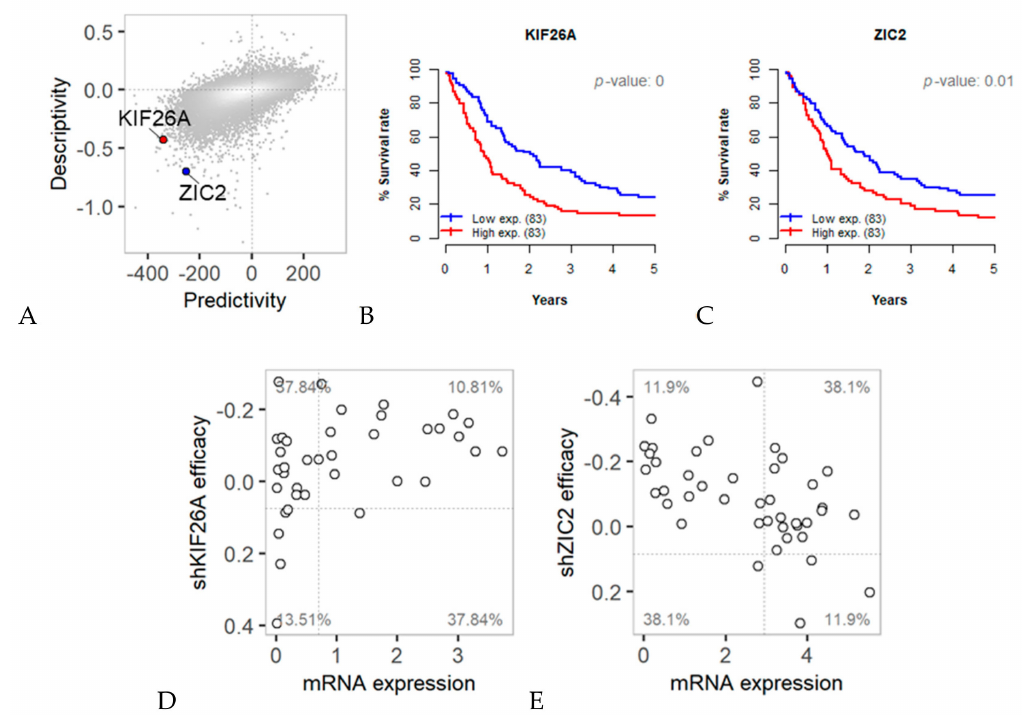
Figure 7. Bidirectional predictivity and descriptivity analyses of 19,079 genes in samples from 171 COAD TCGA patients. mRNA expression of a gene and the survival record of the patient from which the sample was obtained were used for bidirectional calculations. ( A ) Predictivity vs. descriptivity between mRNA expression and disease-free survival in days are plotted. Genes showing positive or negative association with a predictivity p -value < 0.01 and descriptivity p -value < 0.05 were selected. Among 322 hit genes, KIF26A and ZIC2 are common among shRNA hit genes and showed positive and negative correlations in shRNA analysis, respectively. ( B , C ) Graph of disease-free survival according to high and low gene expression of KIF26A and ZIC2 , respectively. ( D , E ) mRNA expression vs. shKIF26A / shZIC2 e ffi cacy in colon cancer cell